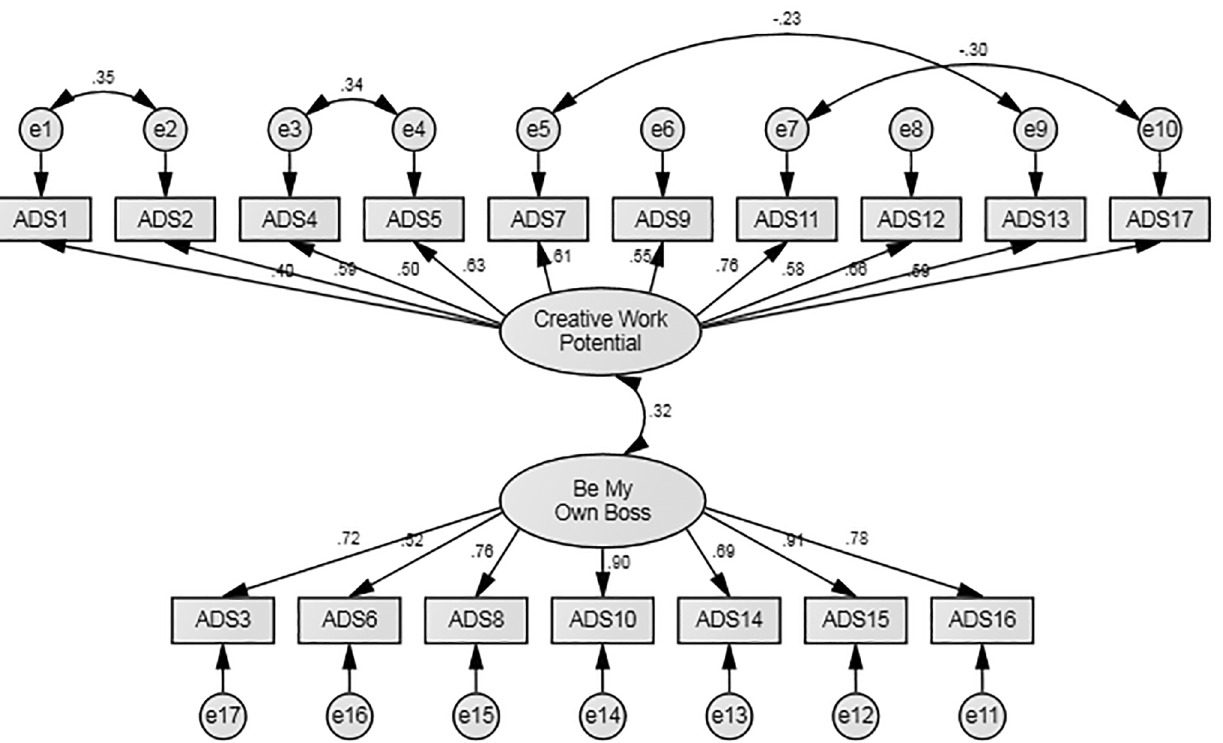
Figure 1. Confirmatory factor analysis for two-factor ADS model. Latent constructs are shown in ellipses, and observed variables are shown in